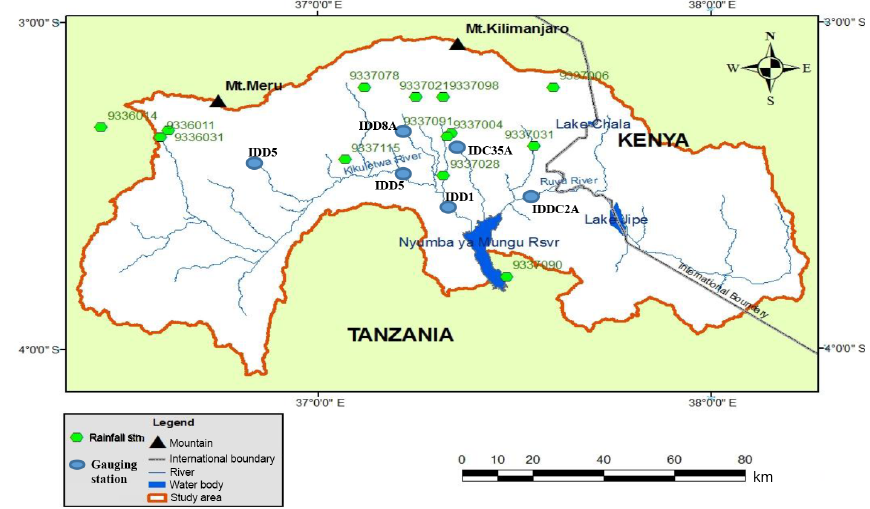
Figure 1. Location of Ruvu and Kikuletwa catchments (upper Pangani).